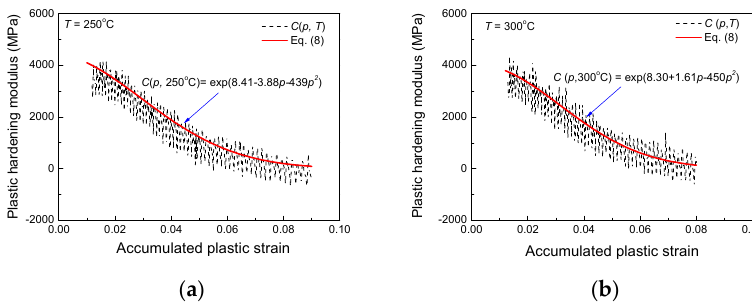
) , C p T and accumulated Figure 2. Exponential curves between the plastic hardening modulus C ( p , T ) and accumulated plastic